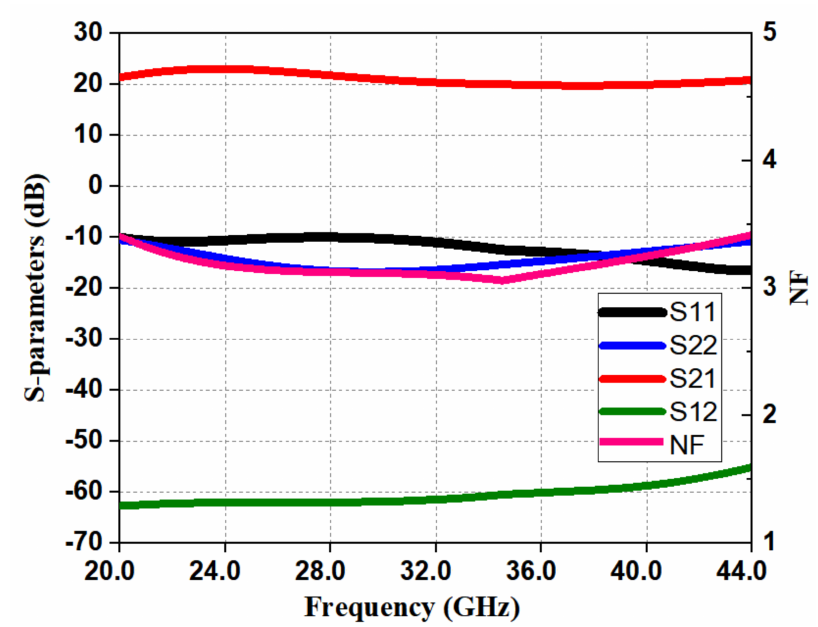
Figure 13. Simulated S parameters of the